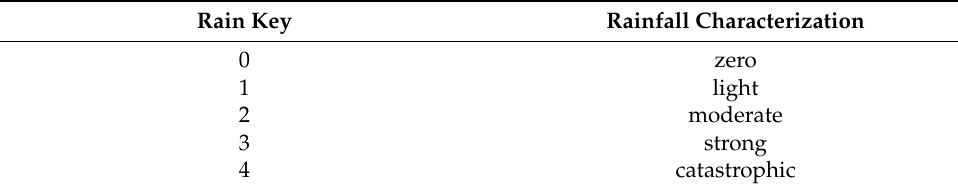
Table 2. Rainfall categories. Rain